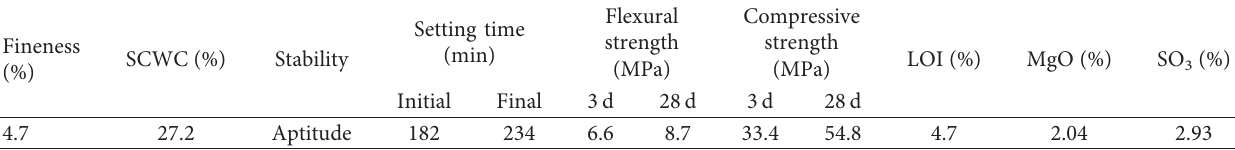
Table 1: Cement performance.